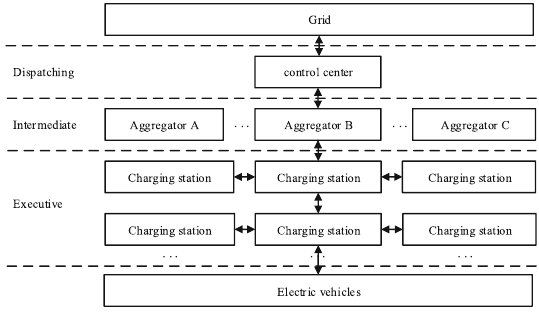
Fig. 1 Hierarchical control of EVs